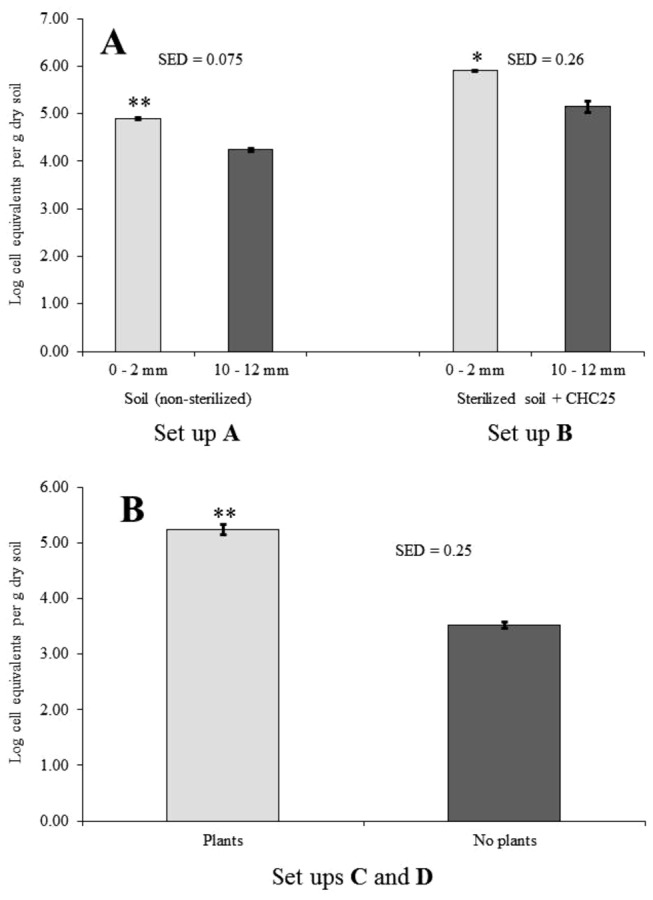
Colonization of the leek rhizosphere by Holophagae and strain CHC25 in soil.Holophaga cell equivalent numbers were compared in non-sterile soil and sterilized soil (set up A) or in sterilized soil inoculated with strain CHC25 (set up B) at 0-2 mm and 10-12 mm distances from the nylon gauze with roots (A), and between 0-2 mm layers of the systems where a 1-cm of sterilized non-inoculated soil layer was placed between sterilized soil inoculated with strain CHC25 and the nylon gauze with (set up C), or without leek roots (set up D) (B). Bars on top of columns represent standard errors of means. SED = Standard error of difference; * or **, significantly different at levels of, respectively, 0.01 ≤ P < 0.001 and P ≤ 0.001.